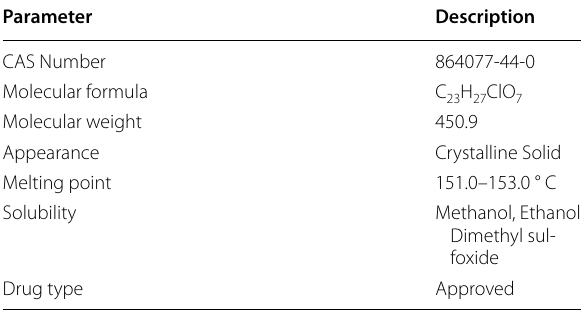
Table 1 Critical physico-chemical parameters